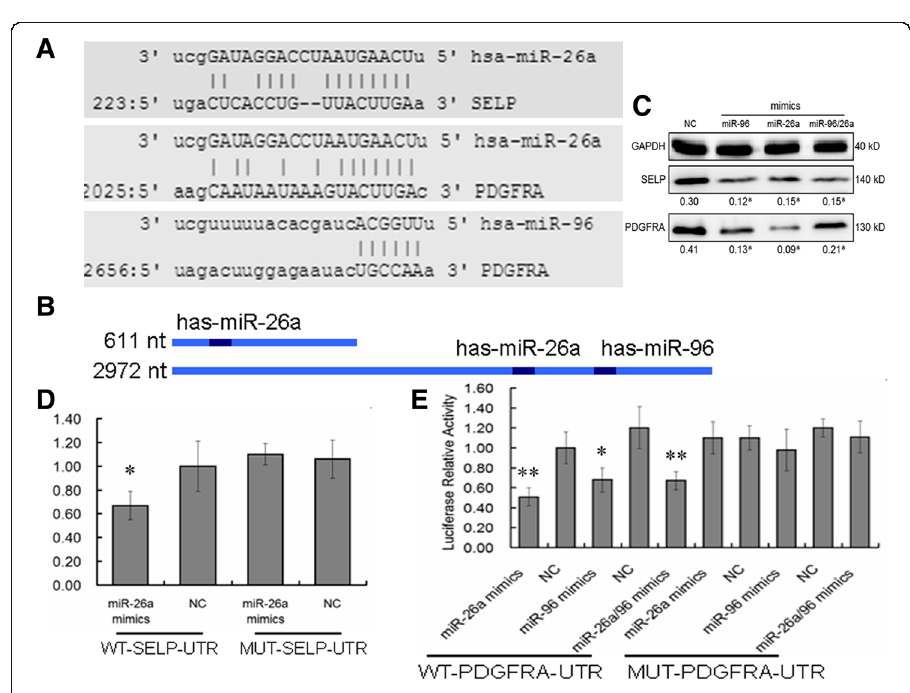
Fig. 4 miR-96 and miR-26a downregulate SLEP and PDGFRA. a and b The sequence sites of miR-96 and miR-26a and the binding UTR of SLEP and PDGFRA. c miR-96 and miR-26a inhibit the expression of SLEP and PDGFRA at the translational level in HUVECs in vitro. The protein bonds are reduced in both groups. d and e The luciferase activity assay with the SLEP and PDGFRA UTRs. MiR-96 and miR-26a reduced the expression of SLEP and PDGFRA by targeting their UTRs. However, these miRNAs did not affect the activity of luciferase gene-containing mutant UTR. * p < 0.05, ** p < 0.01). WT: wild-type (WT-UTR contains the binding site of miR-96 or miR-26a), MUT: mutant (MUT-UTR deletes the binding site of miR-96 or